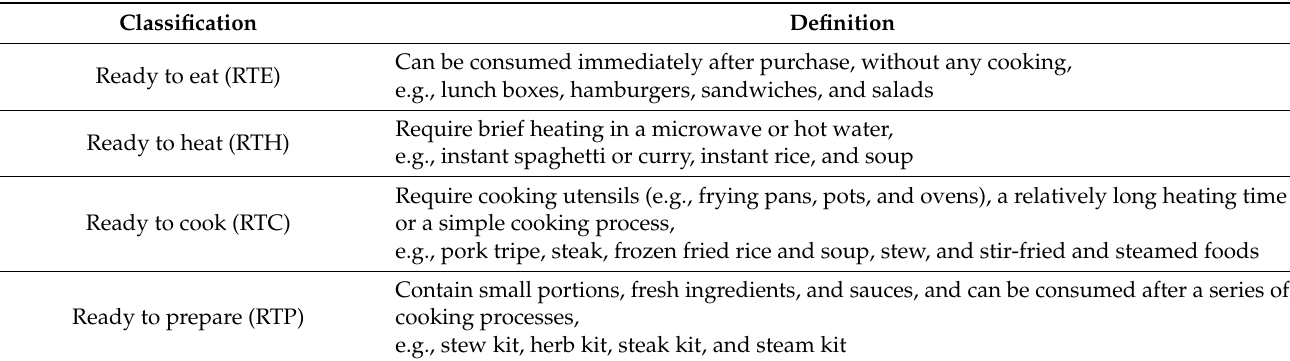
Table 1. Classifications and descriptions of home meal replacements